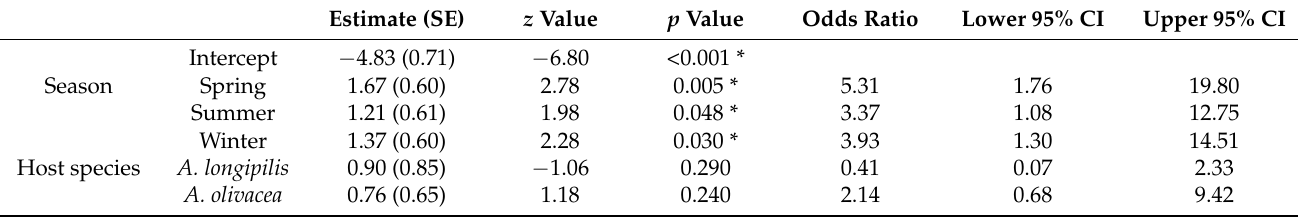
Table 6. Results of the best GLM that predicted the probability of positivity for Physaloptera sp. in rodents. Autumn and O. longicaudatus were used as the reference categories. Hosmer-Lemeshow test: χ 2 = 2.43, p = 0.97 ( p > 0.05 is interpreted as fit). p